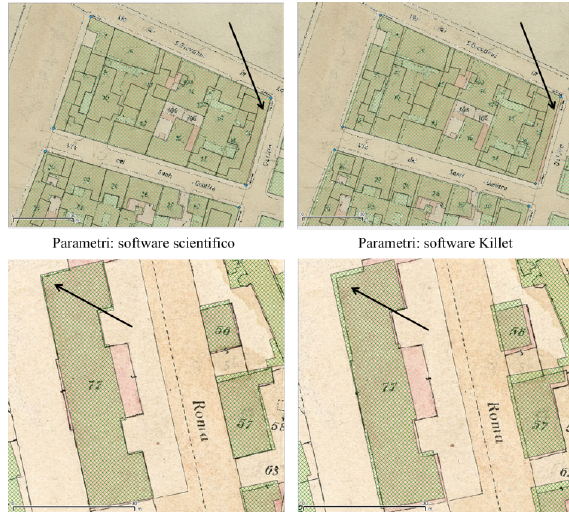
Figure 3. Comparison between cadastral maps and modern cartography. Up: Piazza del Colosseo. Bottom: Castelnuovo di Porto